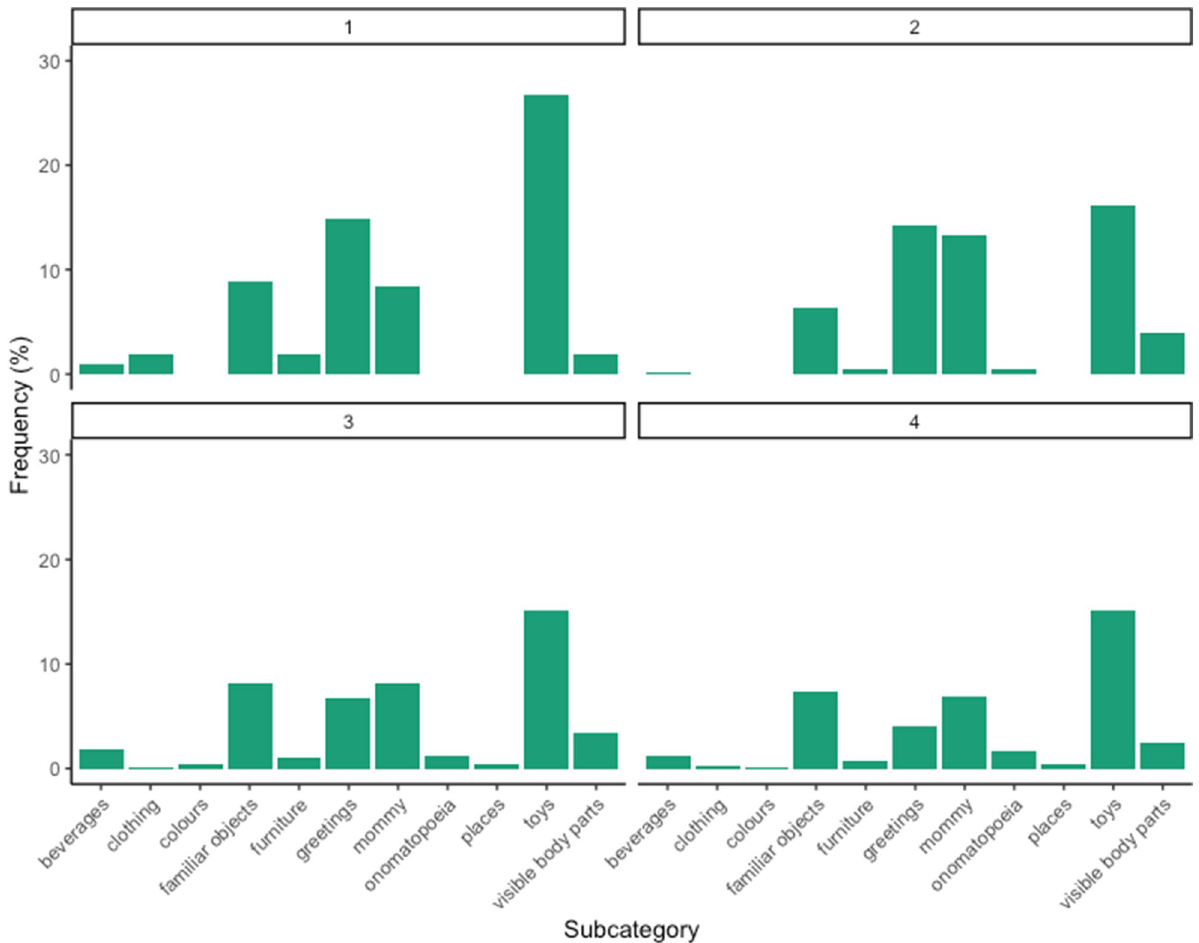
Figure 2. Percentage of words produced by children of age group 1 (12–15 months), age group 2 (16– 18 months), age group 3 (19–21 months), and age group 4 (22–24 months) for concrete between age group 1 (12–15 months, 35.81% of variance) and age group 4 (22–24 months, 30%), while on Dimen- sion 2, age group 2 (16–18 months, 60.21%) is opposed to age group 3 (19–21 months, 15.39%). Dimension 1 features the traditional opposition between abstract (39.9%) and concrete (57.89%) concepts, while on Dimension 2, we find medium concepts (72.62%) opposed to abstract concepts (22.28%). Results from the correspondence analysis suggest that children in the first age group (12–15 months) pro- duced more concrete concepts, whereas they produced more abstract concepts as they grew older (age group 4, 22–24 months). As for the middle-aged groups, we found children in the second age group (16–18 months) pro- duced more abstract concepts, while children in the third age group (19–21 months) mainly produced concepts at an intermediate level of abstractness. The last result might not seem intuitive, but it accounts for a very small percentage of the variance (4%), and it can be considered marginal. It can, however, remind us that the process